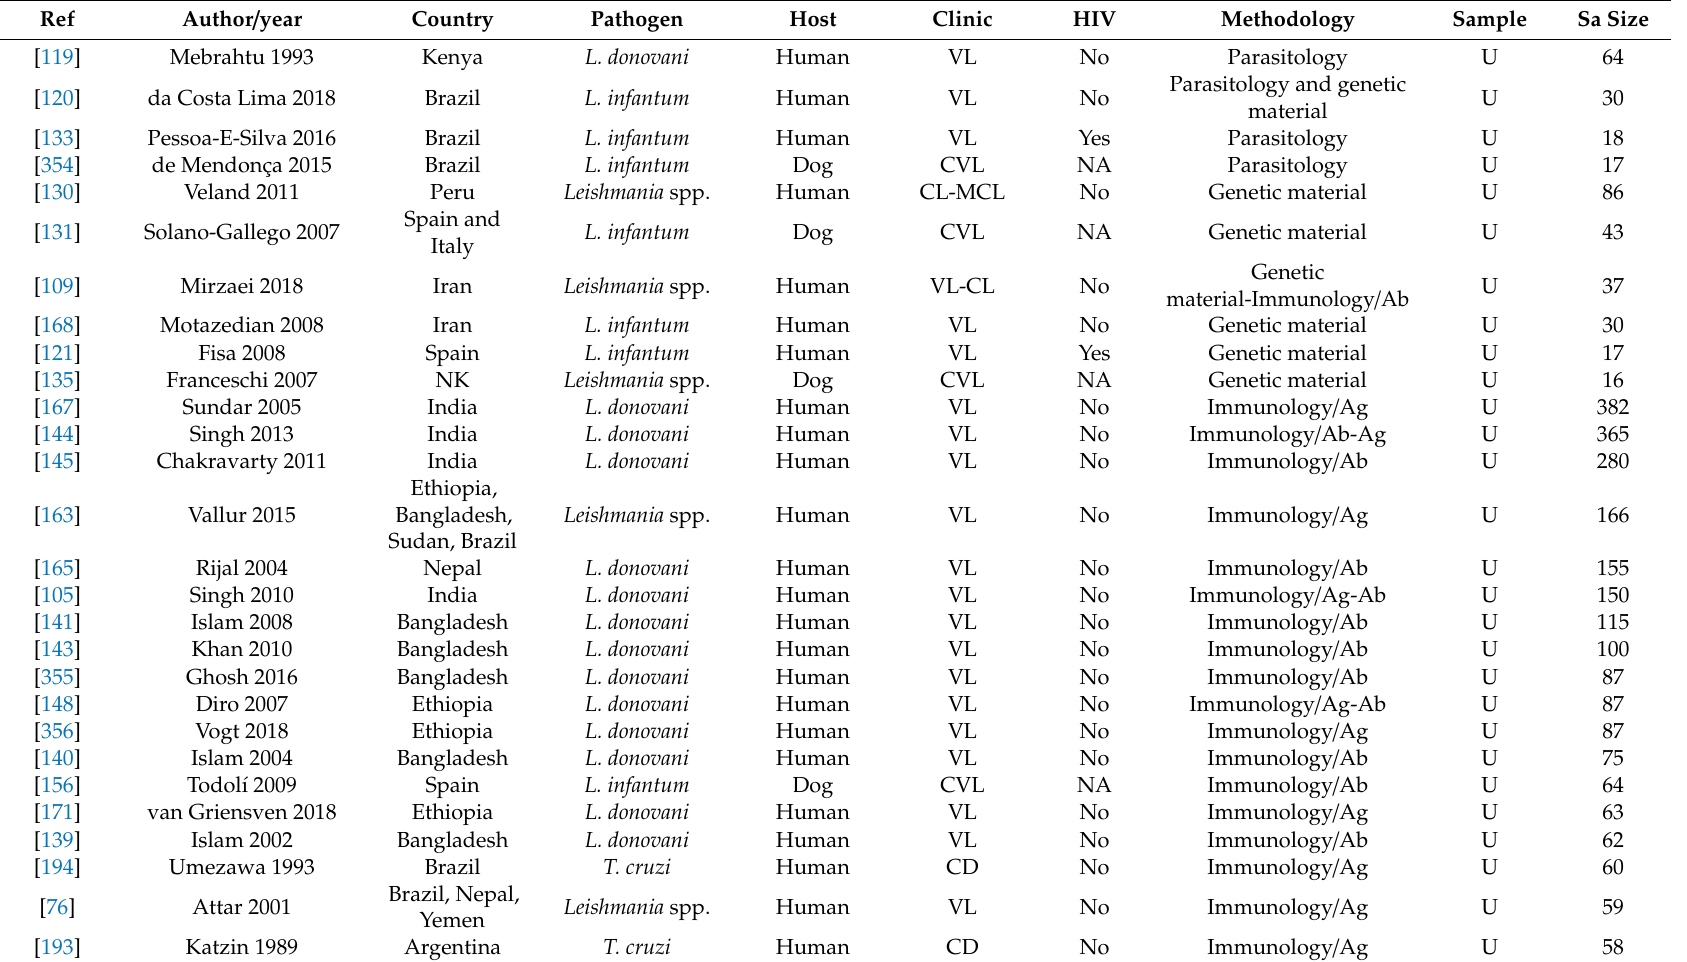
Table 2. References and characteristics of the studies from which data can be